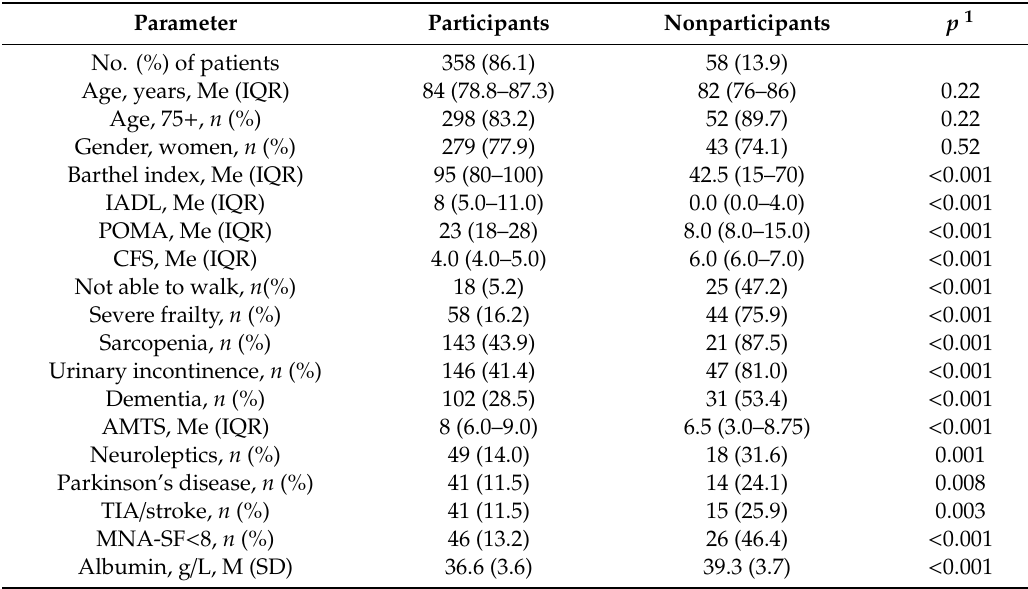
Table 4. Characteristics of participants and nonparticipants of the